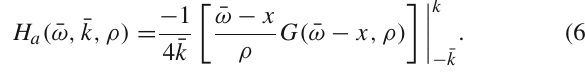
Fig. 5 Thereal(upperplot)andimaginary(lowerplot)partoftheshear channel retarded correlation function, G 0 x , 0 x 0 . 4 and plotted as a function of complex ¯ ω . The function G 0 x , 0 x is calculated according to Eq. (40) with integral moments evaluated according to (53) from the generating function H a in